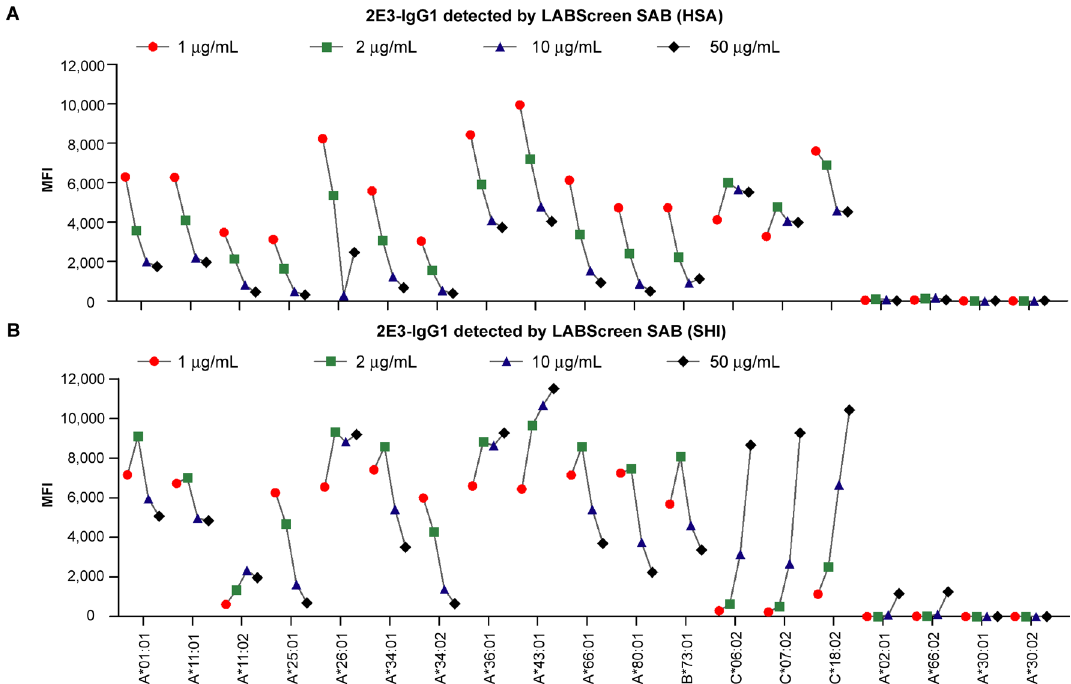
Figure 4. Prozone effect observed for 2E3-IgG1 at increasing concentrations as identified by the SAB assay. MFI of 2E3-IgG1 at 1 μg/mL, 2 μg/mL, 10 μg/mL and 50 μg/mL were connected with lines and plotted against the allele for both tests performed ( A ) at HSA and ( B ) at SHI. All 2E3-reactive HLA Class I alleles, two cross- reactive alleles (A*02:01 and A*66:02) and two non-reactive alleles (A*30:01 and A*30:02) are shown in the figure. SAB single antigen beads; MFI mean fluorescence intensity; HSA Heath Sciences Authority, Singapore; SHI Shared Health Inc., Canada; HLA human leukocyte